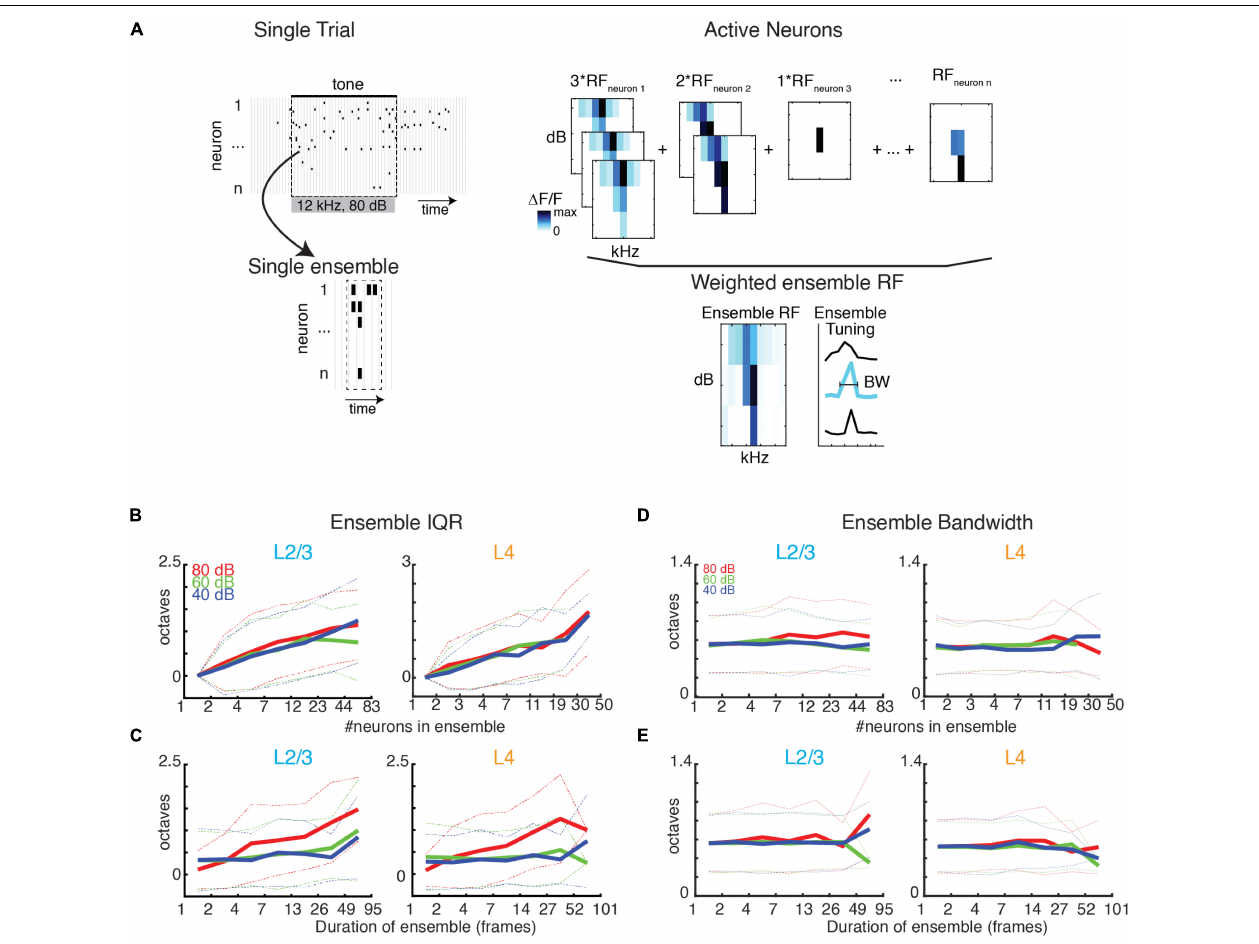
FIGURE 6 | BF variability increases with ensemble size and duration, but bandwidth stays constant. (A) Illustration showing the assembly of the ensemble RF from the weighted average of the RFs of individual neurons active in the ensemble. (B,C) Ensemble IQR BF as function of ensemble size (B) or duration (C) . IQR BF are binned according to logarithmically spaced bins of size and duration. Solid lines indicate mean. Dashed lines indicate one standard deviation. (D,E) Conventions as in (B,C) , but for ensemble